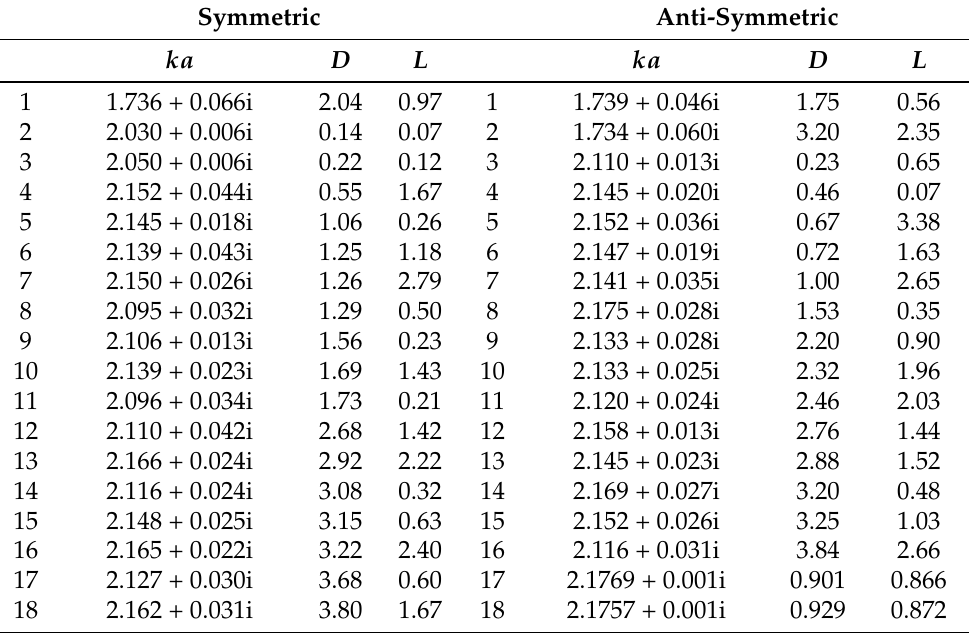
Table 1. The eigenfrequencies of EPs with corresponding